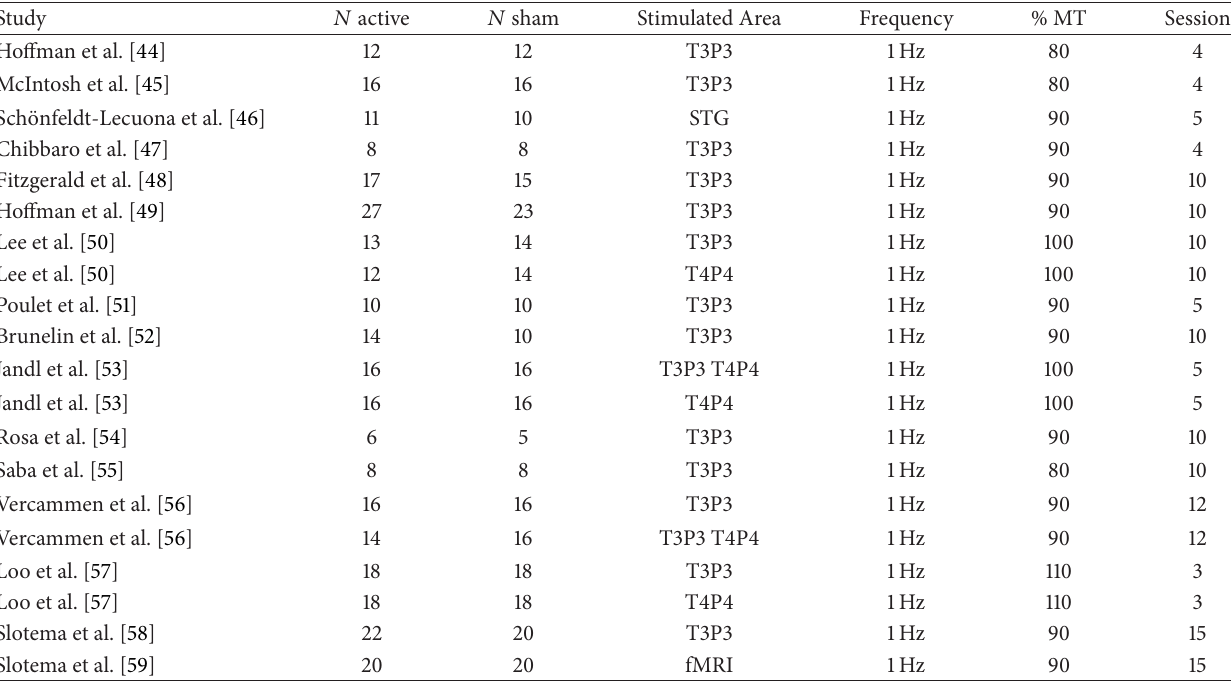
Table 1: Previous rTMS for AVHs